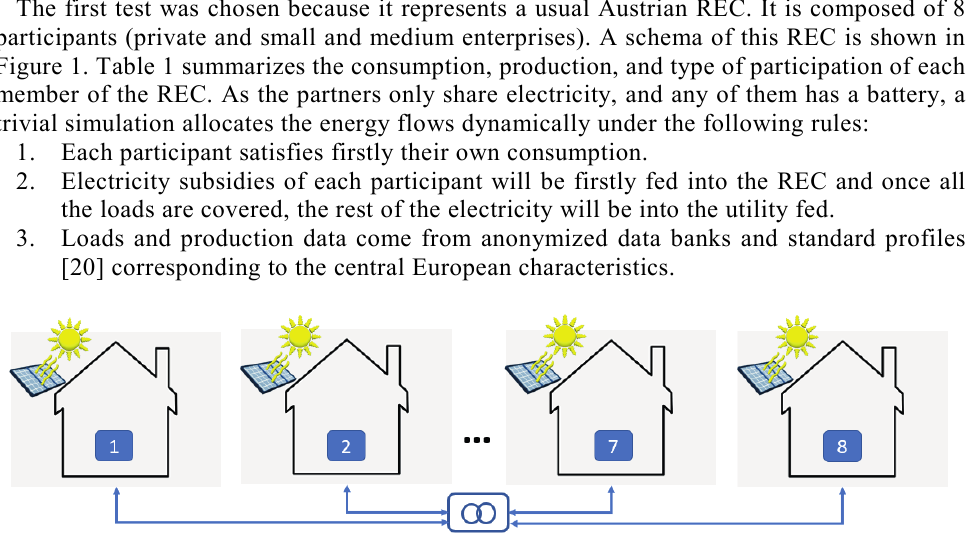
Fig. 1. Schema of the REC used to illustrate the test case